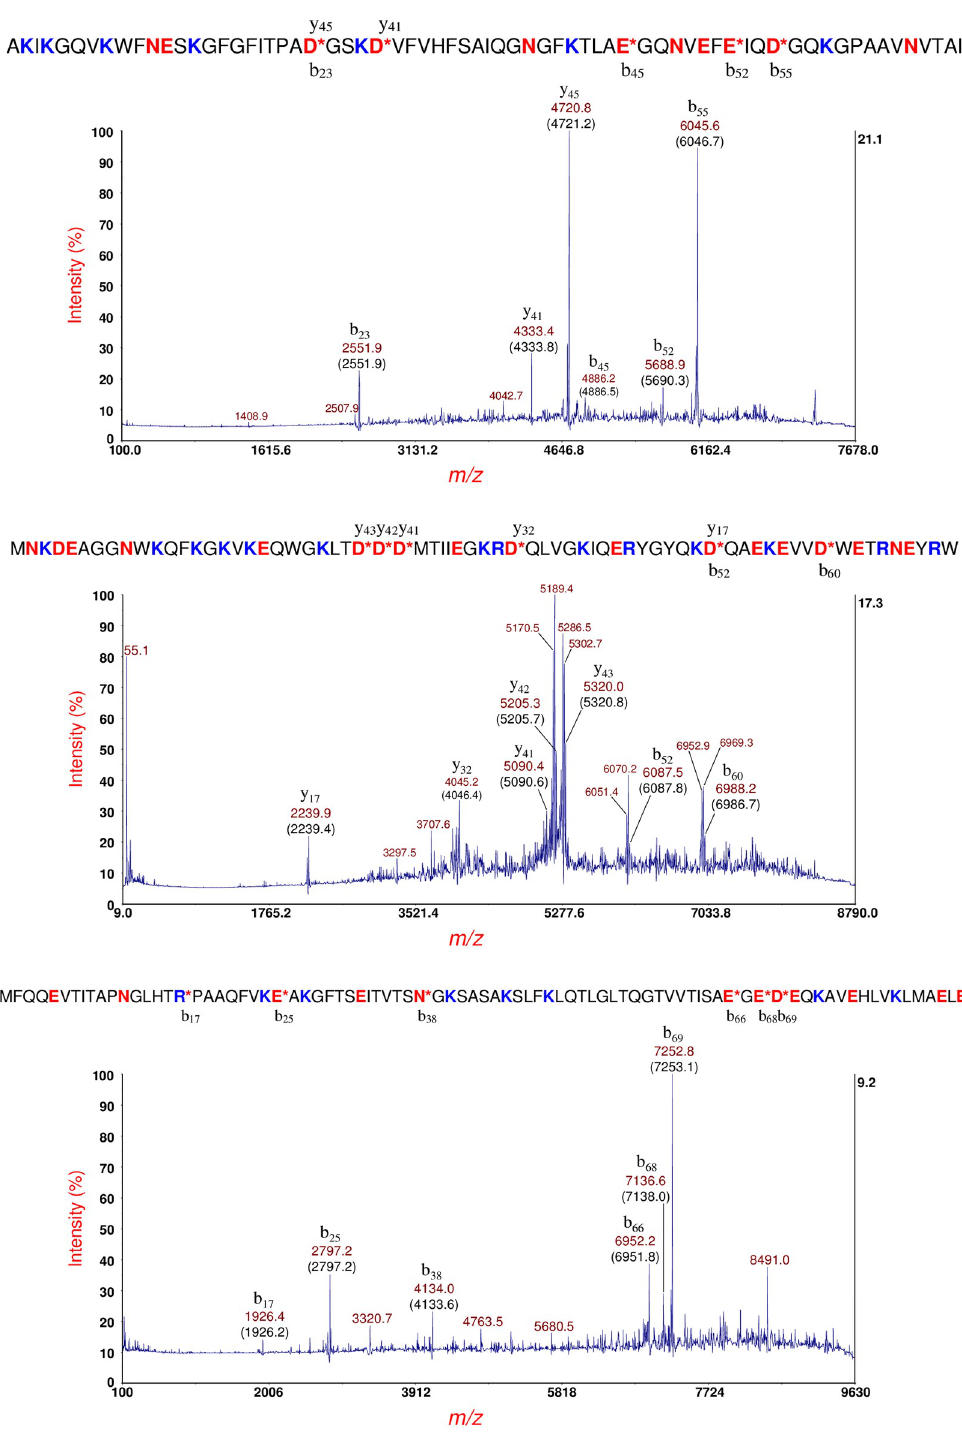
Fig 3. Top panel: MS/MS of the putative CspC at m/z 7270 [M+H] + in Fig 2 (bottom panel). Prominent fragment ions are identified by their m/z and their fragment ion type/number (b- or y-type). The theoretical average m/z value is shown in parentheses. CspC protein sequence is provided above the spectrum. An asterisk ( � ) indicates the site of PBC. The resulting fragment ions are shown above and below the sequence. An asymmetric TIS window (-100/+30) was used to eliminate spillover of fragment ions from putative CspE at m/z 7332. Middle panel: MS/MS of the putative CsbD at m/z 8325 [M+H] + (Fig 2, middle panel). Prominent fragment ions are identified. The average theoretical m/z is shown in parentheses. The CsbD sequence is provided above the MS/MS spectrum. Bottom panel: MS/MS of the protein ion at m/z 9119 [M+H] + (Fig 1, bottom panel). The HPr sequence is shown above the MS/MS spectrum.